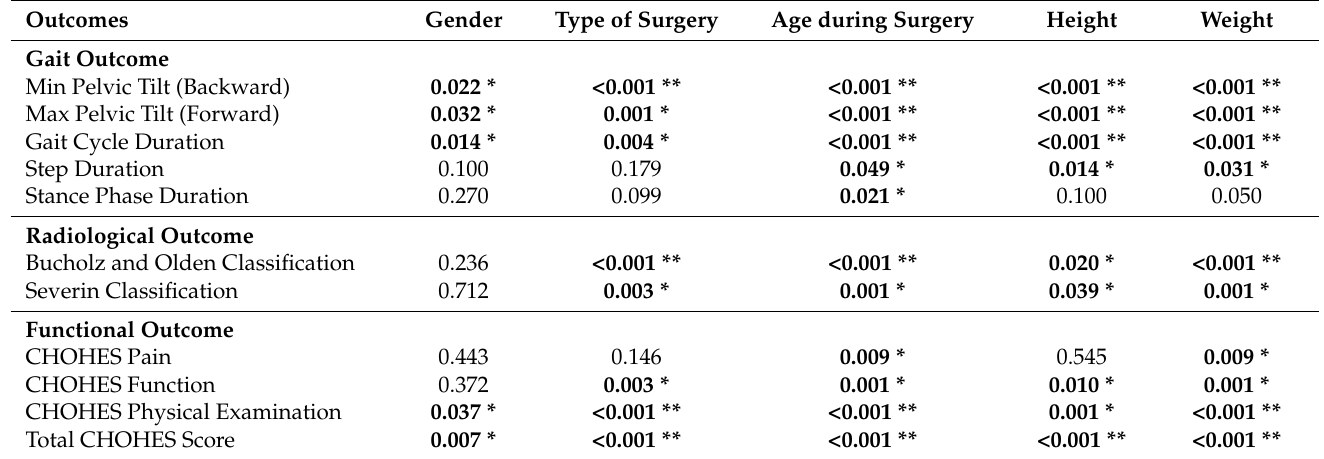
Table 3. Association between risk factors and measured outcome.